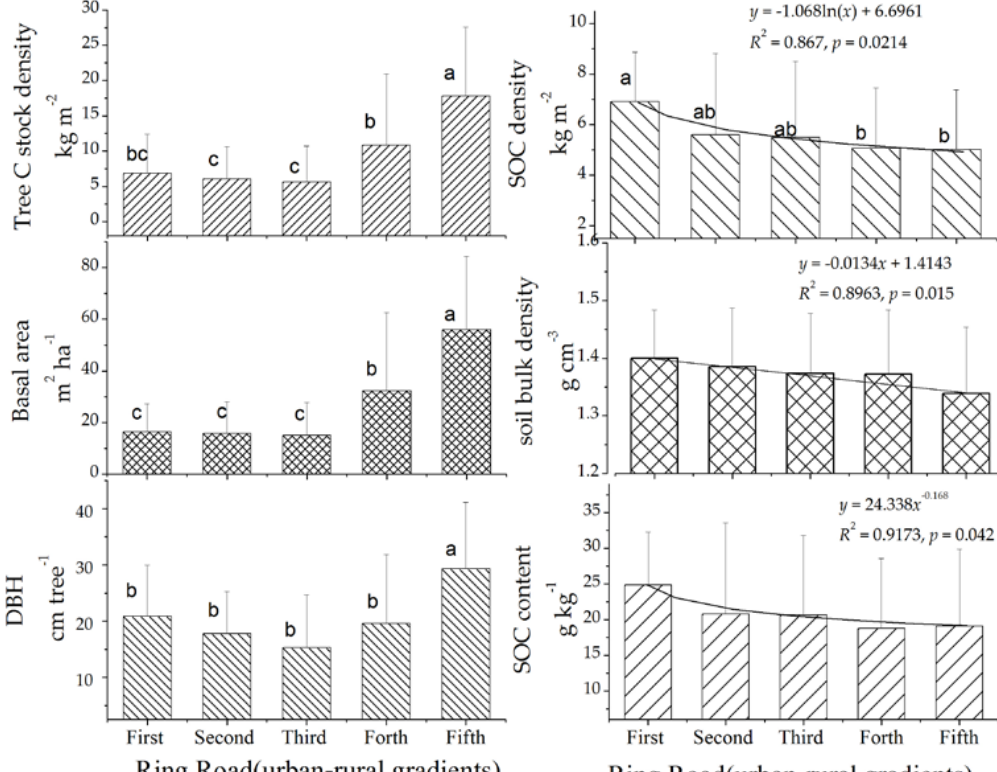
Figure 3. Differences in tree C stock density, basal area, and diameter at breast height (DBH) ( left ), plus differences in soil organic carbon (SOC) density, SOC content, and soil bulk density ( right ) across ring-road-based urban-rural gradients in Harbin City. The same letters (e.g., a and a, ab) indicate no significant differences, and different letters (e.g., a and b, or b and c) indicate significant differences ( p < 0.05) based on the one-way ANOVA test statistics.